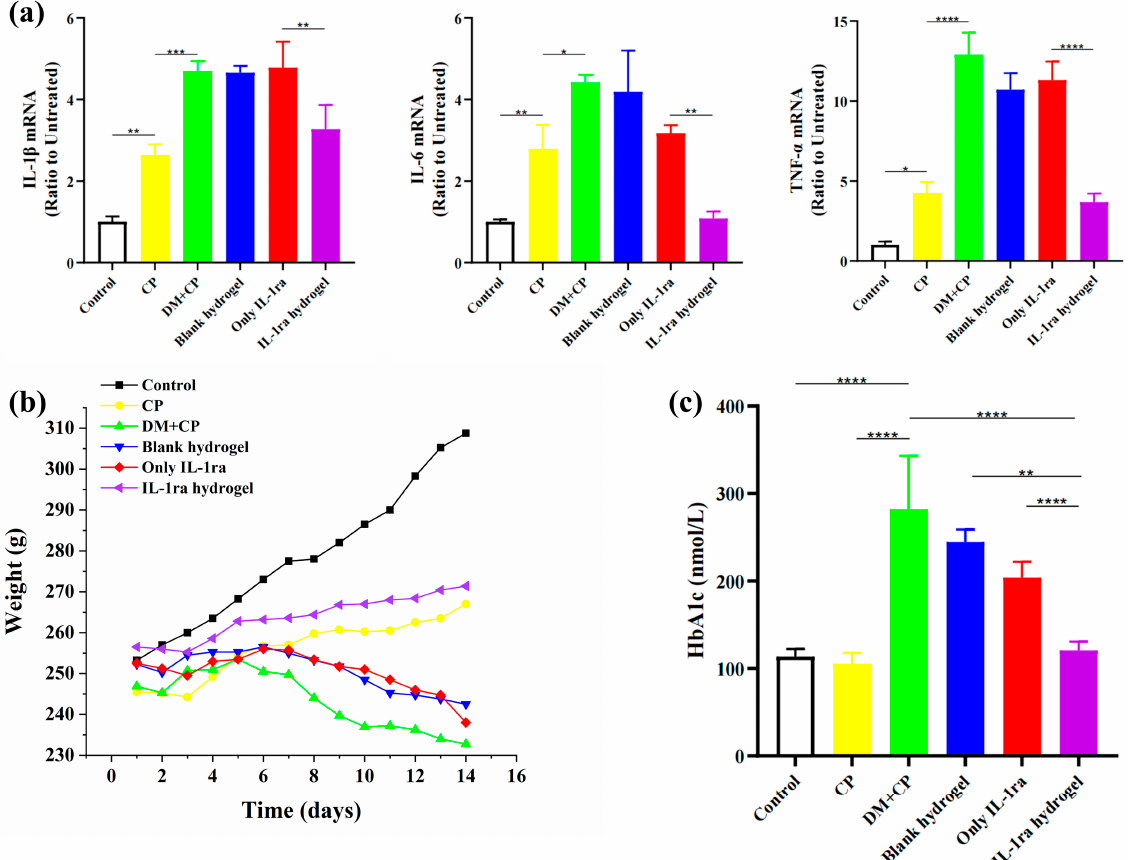
Figure 3. Anti-inflammatory effect of IL-1ra-loaded CS/ β -GP/gelatin thermosensitive hydrogel in vivo and its effect on body weight and blood sugar of rats. ( a ) Fold change of IL-1 β , IL-6, and TNF- α mRNA expression in groups I, II, III, IV, V, and VI. ( b ) Effect of IL-1ra-loaded CS/ β -GP/gelatin thermosensitive hydrogel administration on rat weight. A black line is used to indicate the 14-day weight change in the I group to make the image results more intuitive. ( c ) The content of glycosyl- ated hemoglobin in groups I, II, III, IV, V, and VI. *: p < 0.05, **: p < 0.01, ***: p < 0.001, ****: p < 0.0001.